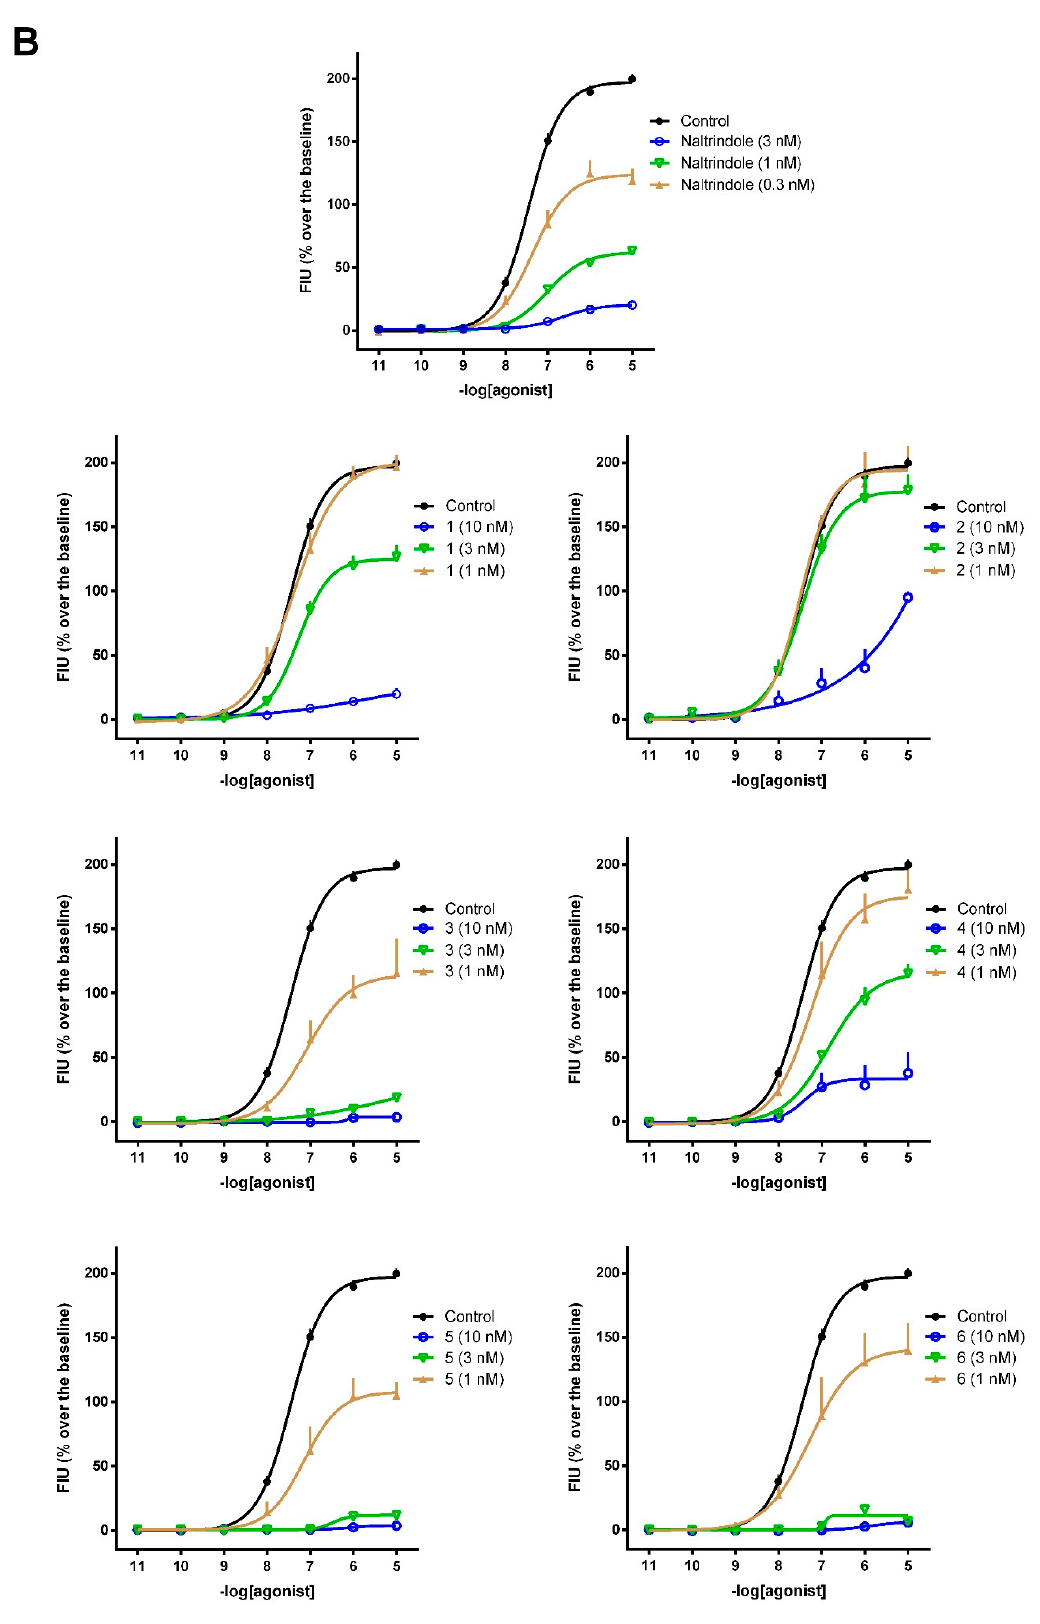
Figure 3. Cont Figure 2. Cont.